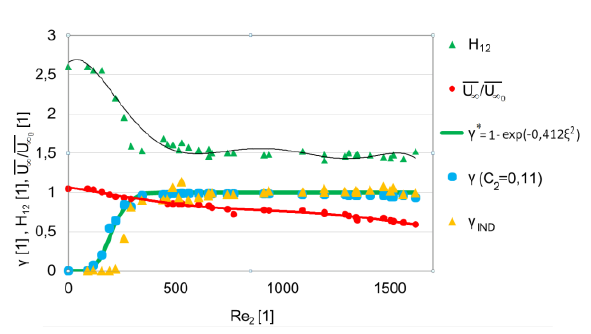
(Re 2 ), H 12 (Re 2 ), γ (Re 2 ), γ(Re 2 ) IND , / UU  0 γ * (Re 2 ), α = 5° , smooth surface of flat plate, Iu e = 0,5%